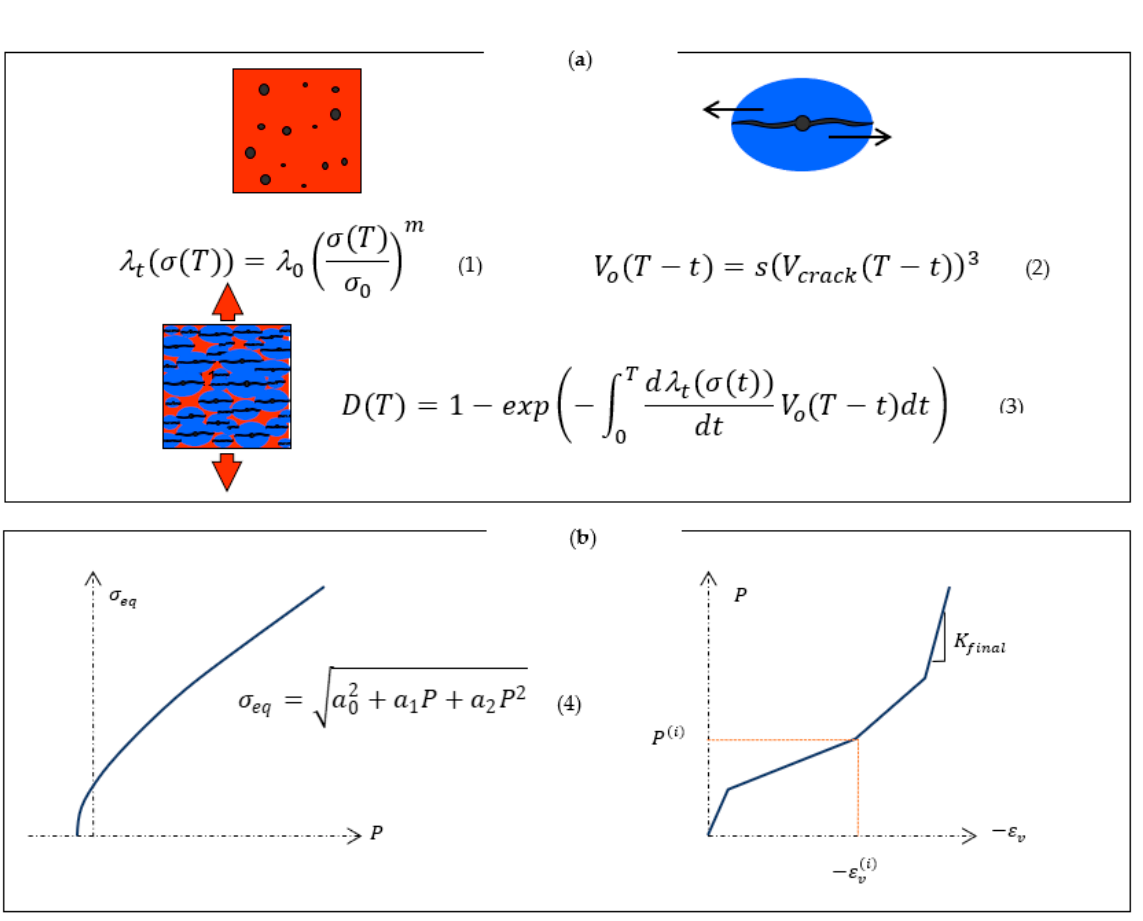
Figure 1. Description of DFH–KST coupled plasticity-damage model. ( a ) DFH (Denoual–Forquin–Hil) anisotropic damage model. ( b ) KST (Krieg–Swenson–Taylor) plasticity model.